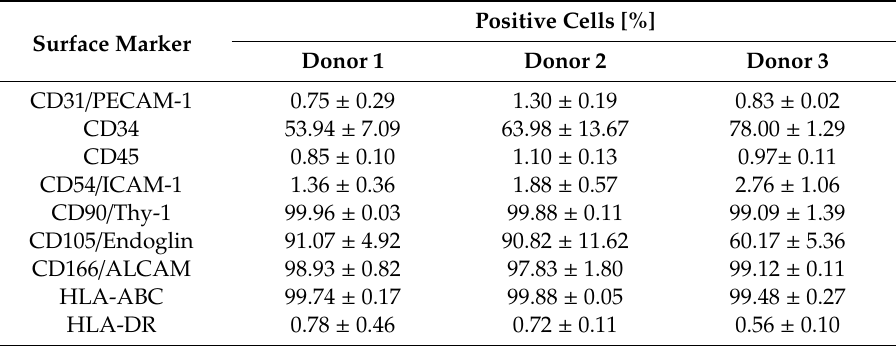
Table 1. Characterization of